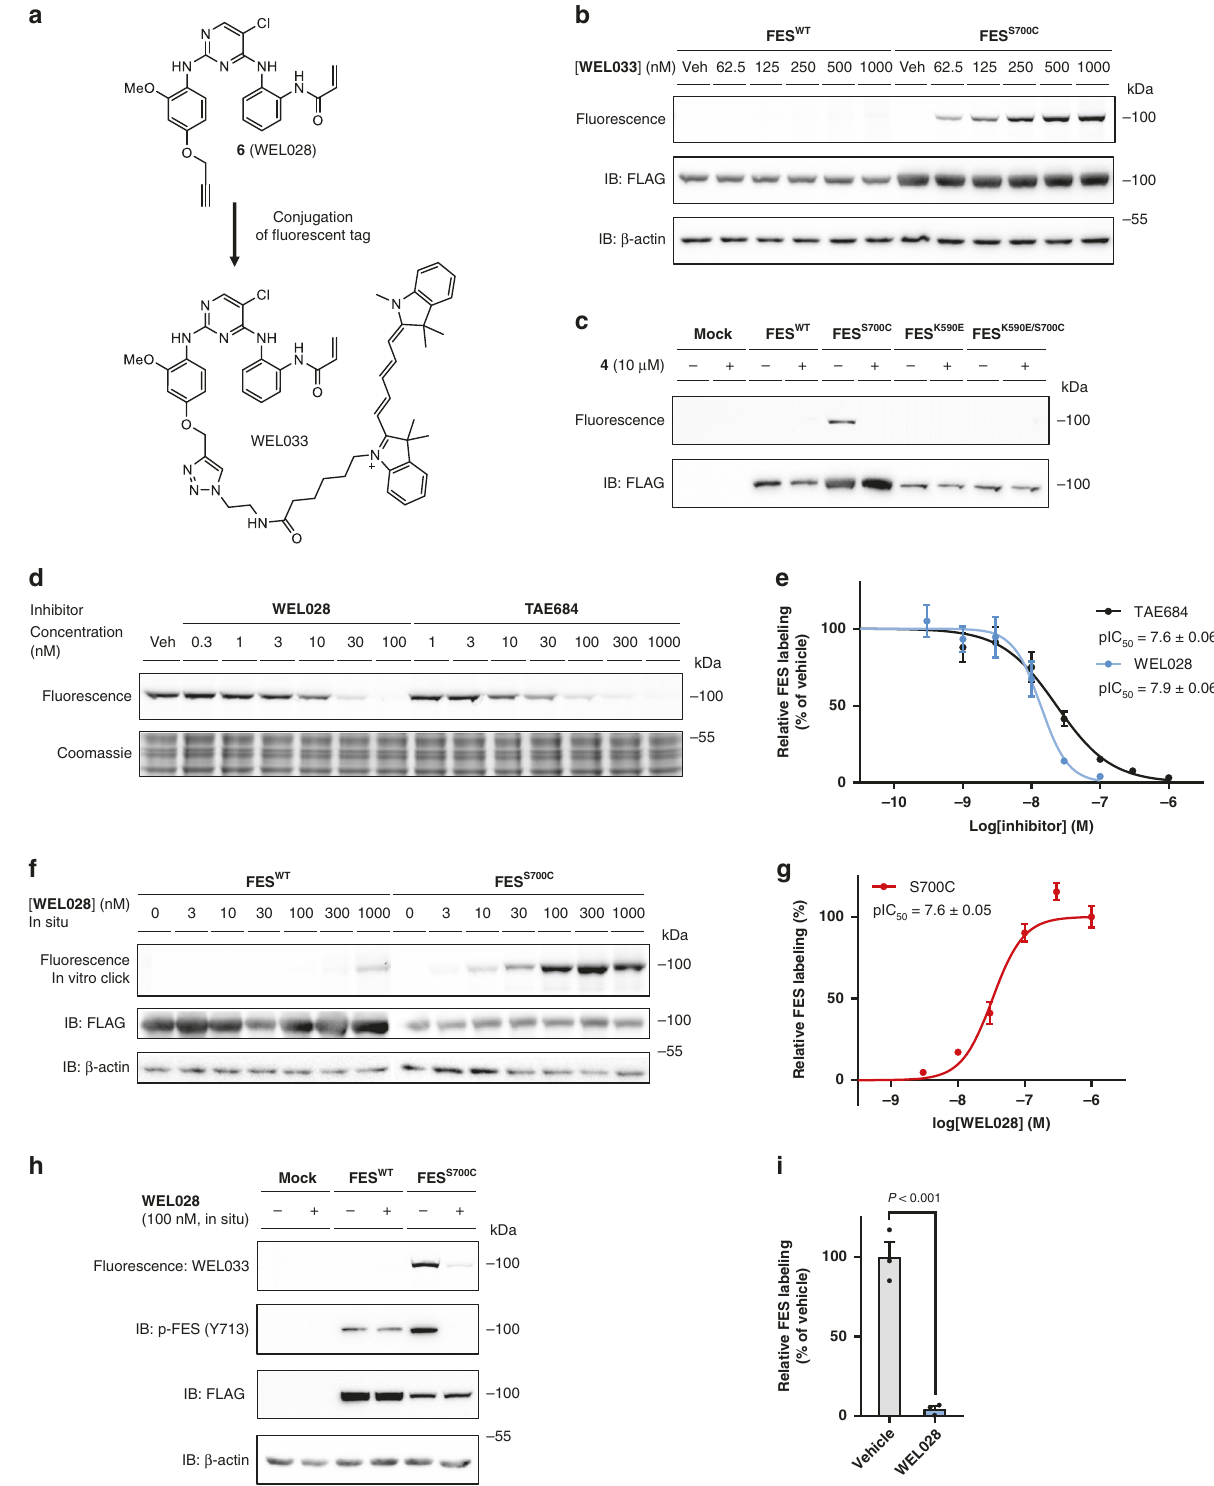
Fig. 4 FES S700C can be visualized by fl uorescent probe WEL033. a Design of fl uorescent probe WEL033 (Cy5-conjugate). b Dose-dependent labeling of full-length FES S700C by WEL033 in HEK293T cell lysate. c Labeling by WEL033 is speci fi c, exclusive for FES S700C and dependent on catalytic lysine 590. Lysates were preincubated with vehicle or 4 and labeled by WEL033 (250 nM). d , e Visualization of FES S700C target engagement by WEL028 and TAE684. Lysate was preincubated with WEL028 or TAE684 and labeled by WEL033 (250 nM). Band intensities were normalized to vehicle-treated control ( n = 3). f , g WEL028 engages recombinantly expressed FES S700C in live cells. Transfected HEK293T cells were treated with WEL028 and labeled proteins were visualized using click chemistry. Band intensities were normalized to highest concentration ( n = 3). h , i WEL028 blocks FES S700C but not FES WT autophosphorylation (visualized by immunoblot using anti-phospho-FES Y713). Band intensities were normalized to vehicle-treated control ( n = 3). Data represent means ± SEM. Statistical analysis: two-tailed t-test: *** P < 0.001. Source data are provided as a Source Data fi